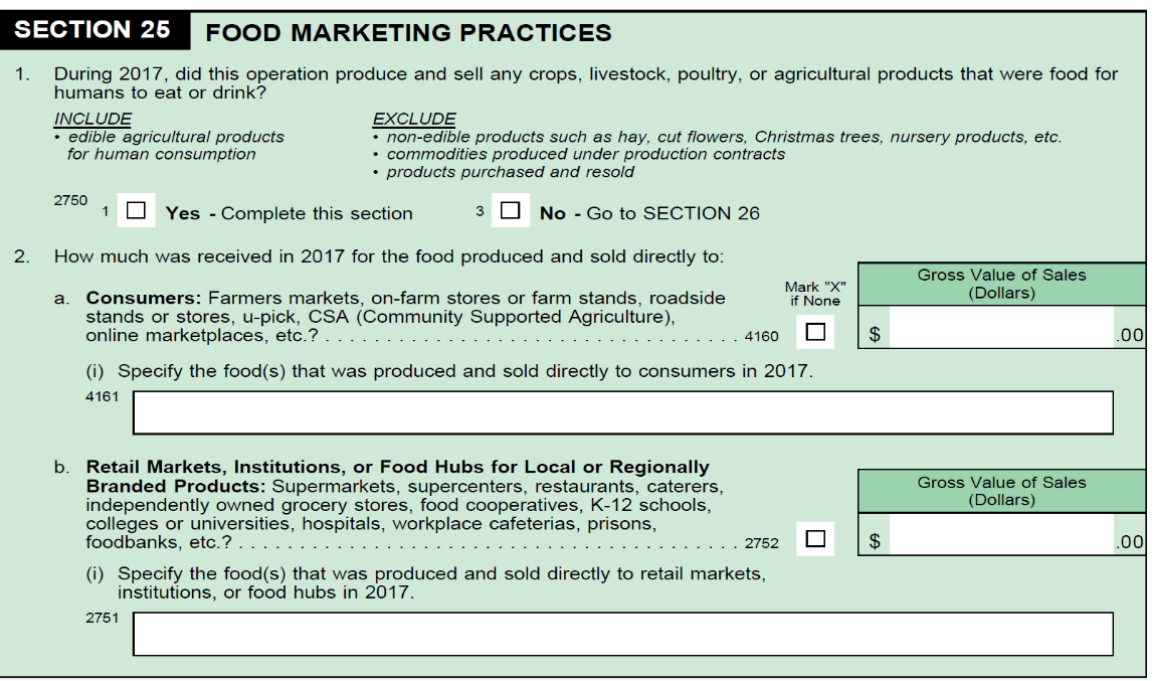
Figure 2. 2017 Census of Agriculture